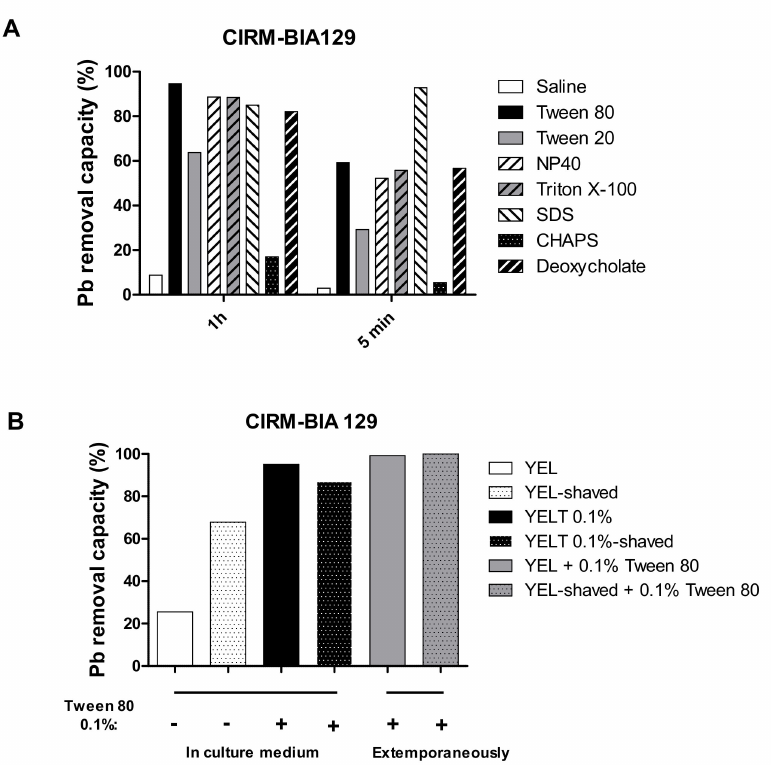
Figure 6. P. freudenreichii ’s Pb(II) removal ability varies as a function of the detergent and the surface protein treatment. ( A ) The effects of seven different detergents (0.05%, added extemporaneously) for 1 h or for 5 min) are shown for the P. freudenreichii strain CIRM-BIA 129. ( B ) CIRM-BIA 129 grown in YEL (white bar) and then “shaved” with trypsin (dotted white bar), grown in YEL, pre-incubated with Tween ® 80 (black bar), and then shaved (dotted black bar), or grown in YEL, exposed to 0.1% Tween ® 80 and the metal ion solution at the same time (grey bar), and then shaved (dotted grey bars). Representative data are expressed as the % of Pb 2+ removed from the 25 ppm initial